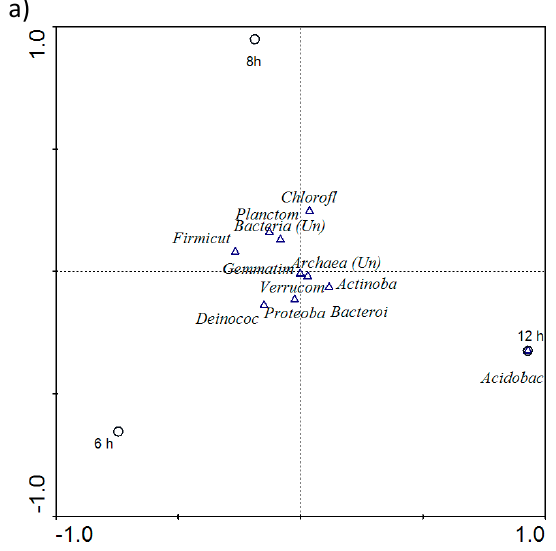
Figure 5. CCA (canonical correspondence analysis) graph showing the effect of cycle length on the composition of microorganisms at the phylum ( a ) and genus ( b ) level; abbreviations: Archaea (Un)— unclassified phylum from Archaea, Acidobac—Acidobacteria, Actinoba—Actinobacteria, Bacteria (Un)—unclassified phylum